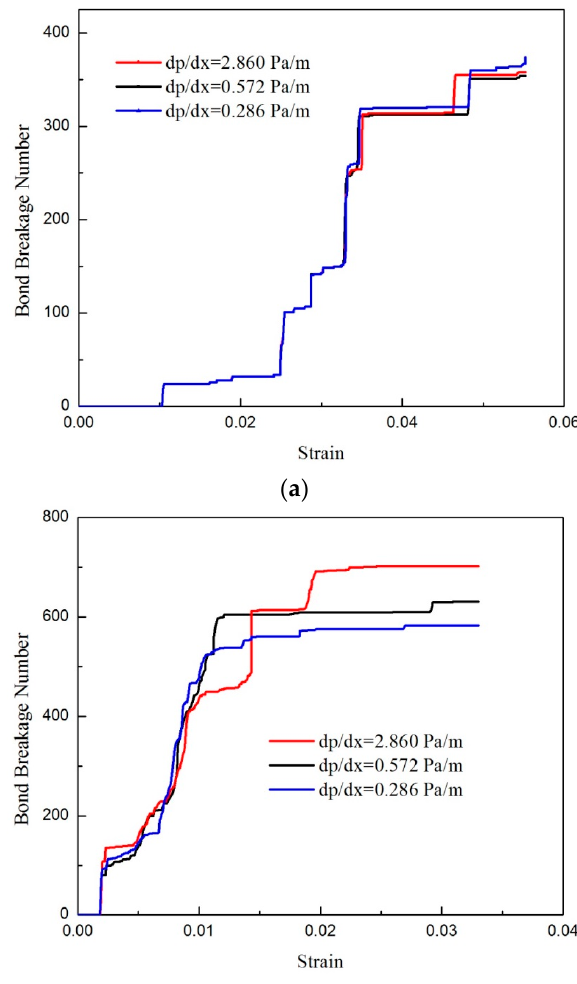
Figure 13. The number of accumulative bond breakage for synthetic cemented materials: ( a ) with high bonding strength 0.078 N; and ( b ) with low bonding strength 0.0078 N under different flow rate.